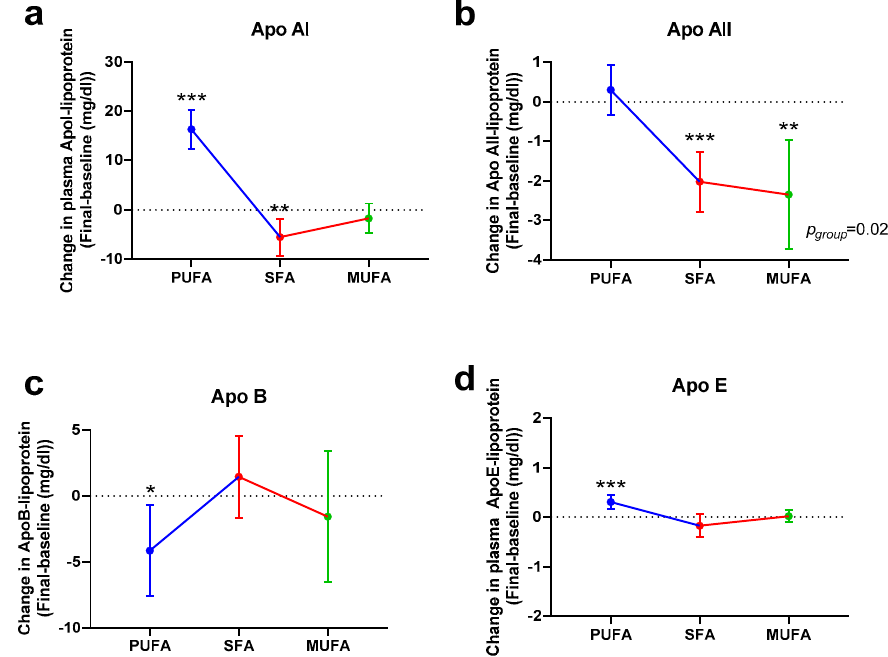
Figure 5. Changes in plasma apolipoproteins (Apo) AI ( a ), Apo AII ( b ), Apo B ( c ), and Apo E ( d ) after 30 days of intervention with the di ff erent breakfasts. Data represent estimated treatment di ff erences (final-baseline) values and the 95% confidence interval (CI). Data derive from those women who completed the study ( n = 53). * represents di ff erences within the same group (final-baseline). * p < 0.050, ** p < 0.010, *** p < 0.001. Within-group di ff erences are indicated as p group . Further information is available at Table S3.